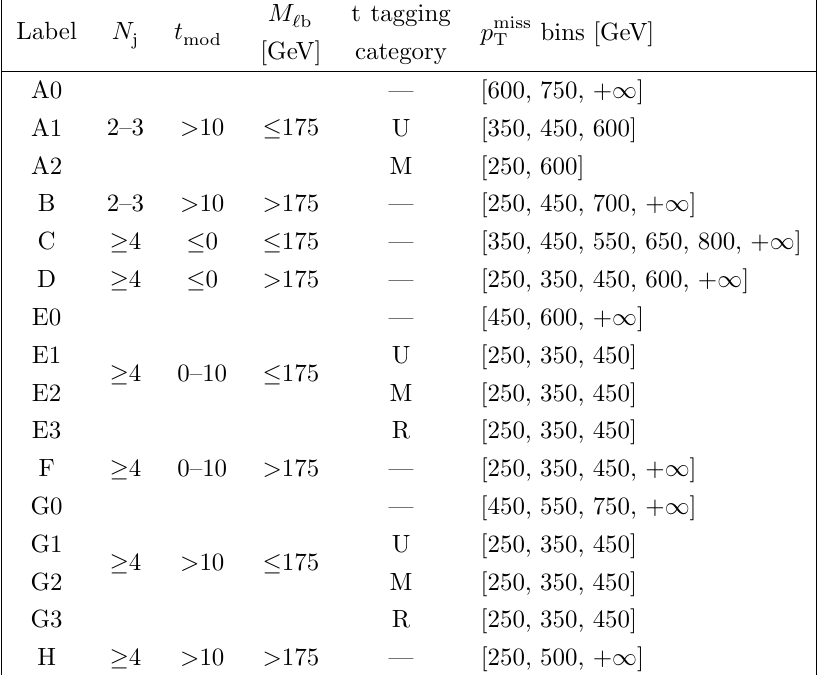
Table 2 . The 39 signal regions of the standard selection, with each neighboring pair of values in the p miss bins column de(cid:12)nes a single signal region. At least one b-tagged jet selected using T